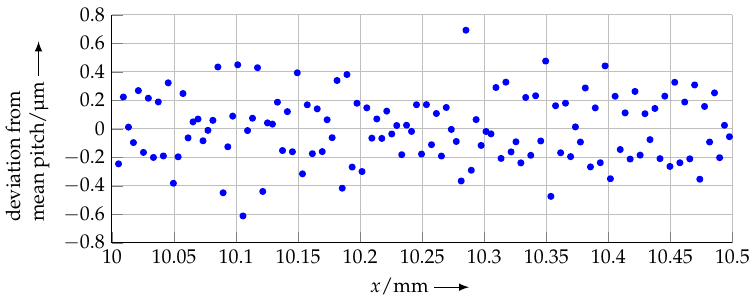
Figure 16. Per-period deviation from mean pitch (detail of complete scan